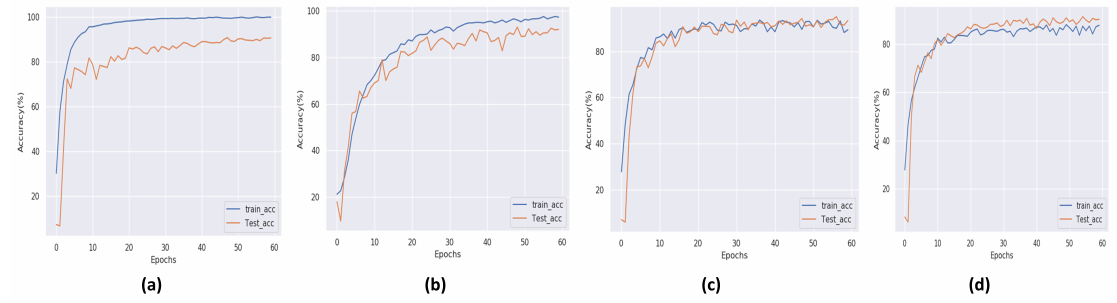
Figure 4. Performance of eXnet on the CK+